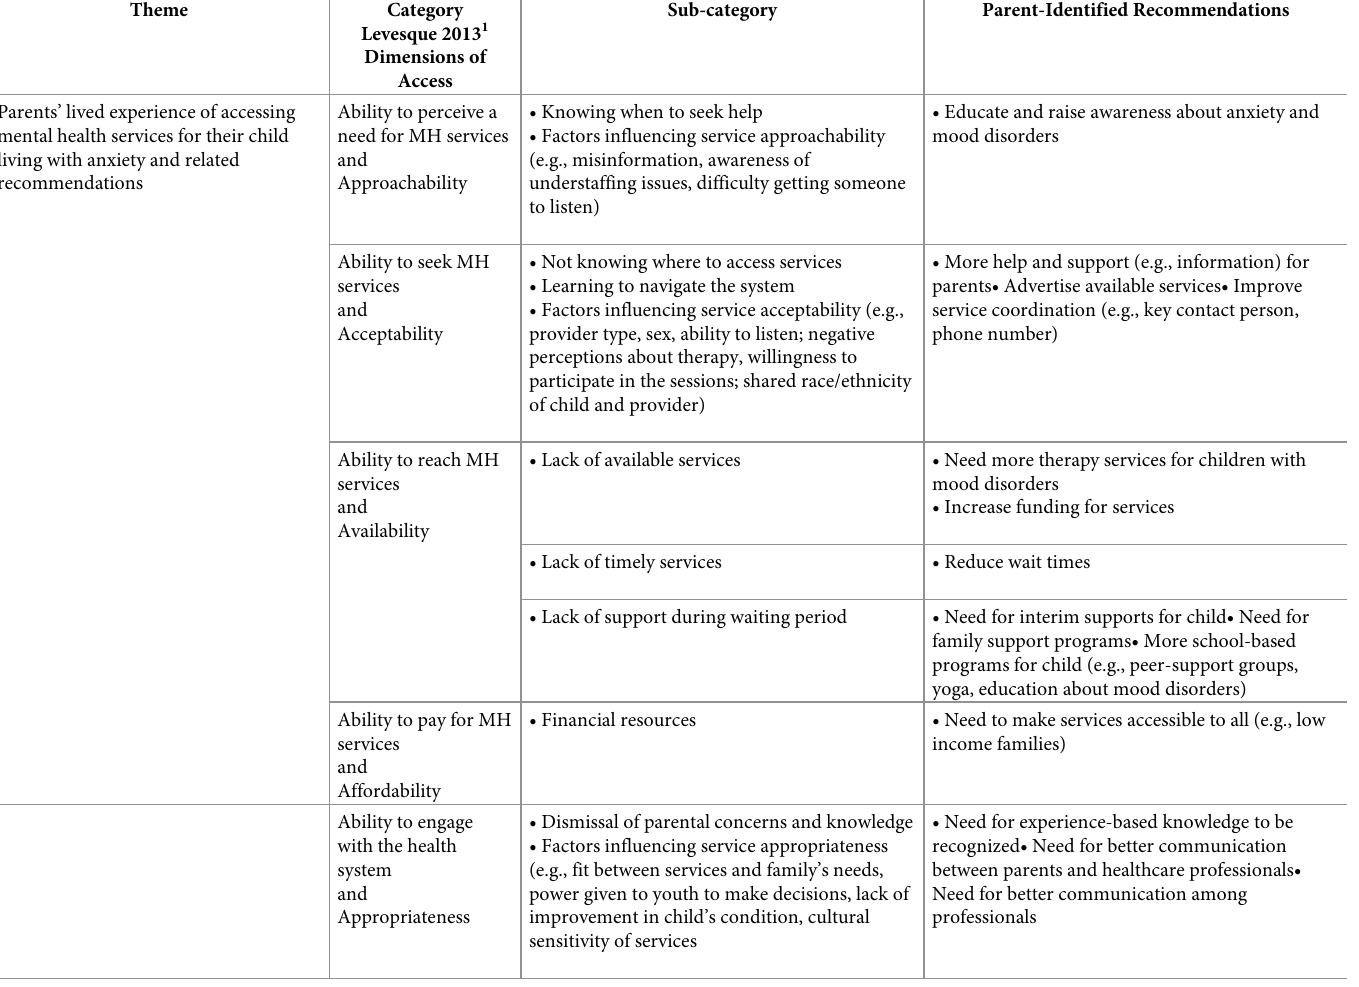
Table 1. Study findings: Overarching theme, categories, and parent-identified recommendations.